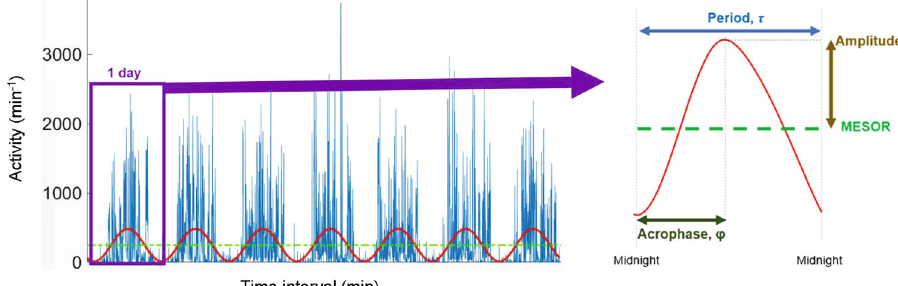
Fig. 2 Cosinor fi t used to extract parametric measures from continuous actigraphy with minute-by-minute activity. Cosinor fi t (red line) used to extract parametric measures over the 7 days of continuous actigraphy data (blue lines) from a sample participant with MDD. Each dot on the plot signi fi es one minute in time and the height of the line indicates motor activity for that minute. 1 day length of data (recorded from midnight to midnight) is indicated by the horizontal length of the purple rectangular box. Amplitude (brown double arrow) is indicated at half the distance between peaks of the fi tted waveform. Acrophase ( φ , dark olive, double arrow) refers to the time of the point of peak activity. MESOR (Midline Estimating Statistic of Rhythm, green dashed line) indicates the average cycle